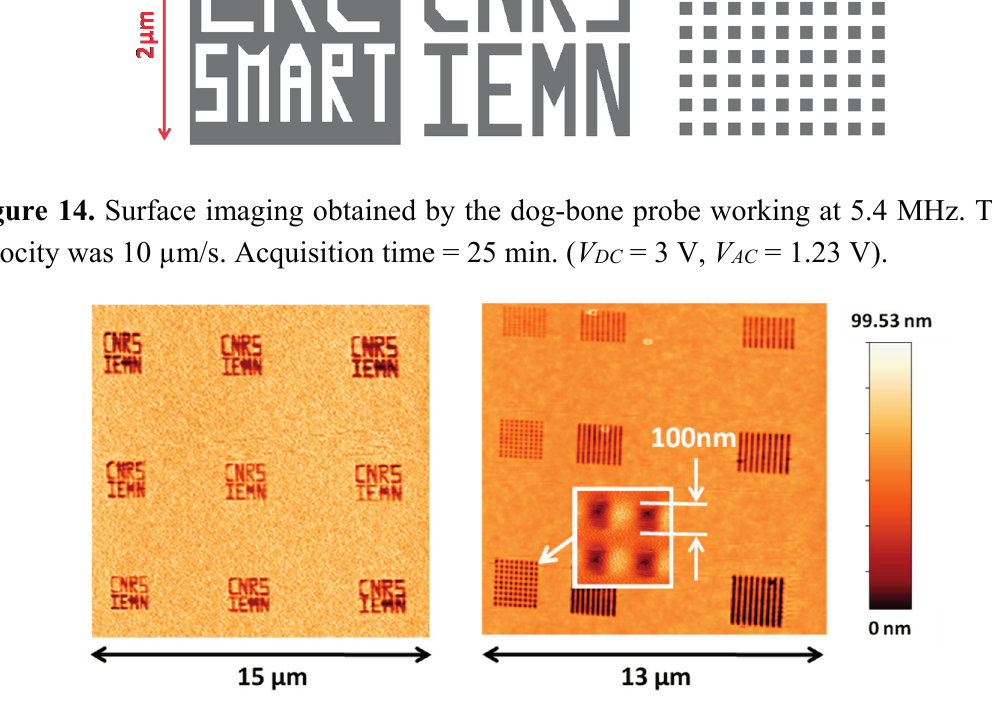
Figure 15. Sample surface AFM topographies obtained by the dog-bone probe working at 5.43 MHz with a tip velocity of 10 µm/s and an acquisition time of 10 min. ( V DC = 3 V, V AC = 1.23